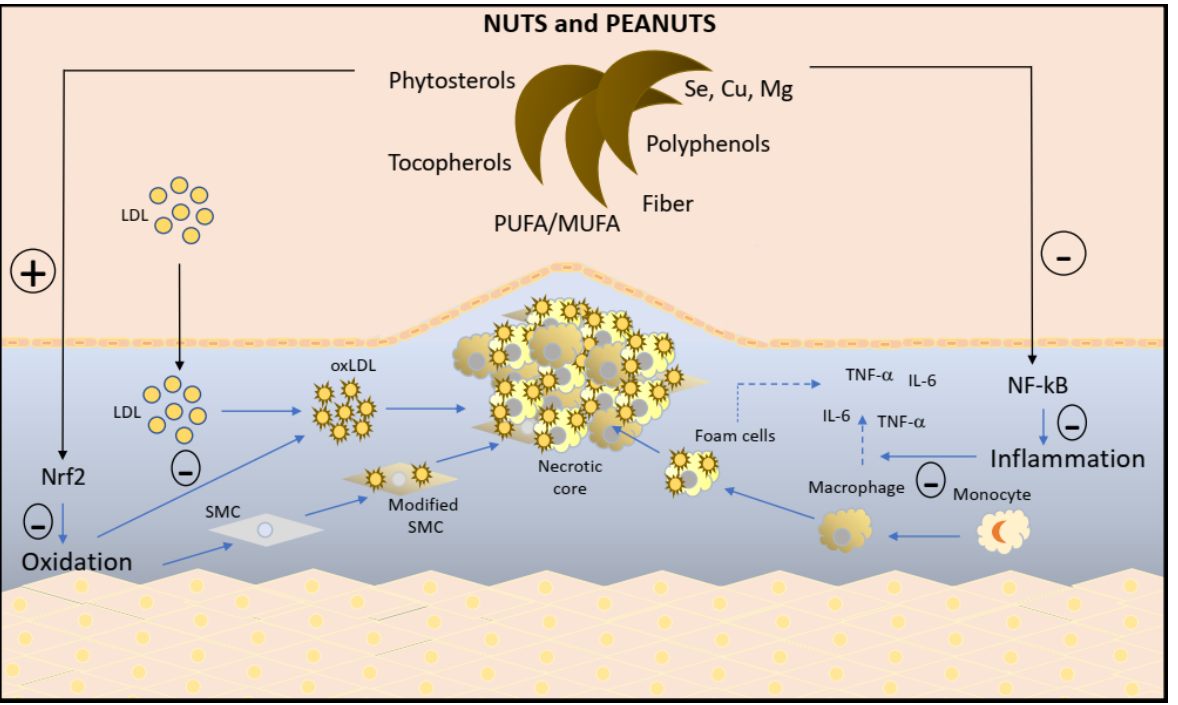
Figure 1. Inflammatory and oxidative processes modulated by nutrients and bioactive substances in tree nuts and peanuts. Fiber, phytosterols, PUFA/MUFA and mineral antioxidants such as Se, Cu, and Mg in tree nuts and peanuts can improve lipid metabolism through a cholesterol-lowering effect on low-density lipoprotein (LDL). Additionally, antioxidants (polyphenols and tocopherols) quench free radicals, avoiding the oxidative modification of LDL (oxLDL). Together, this process prevents monocyte migration and macrophage differentiation, and the consequent endocytosis of oxLDL by macrophages and the formation of foam cells. Increased levels of free radicals in the sub endothelial space stimulate changes in the smooth muscle cell (SMC) phenotype, favoring uptake of oxLDL. This complex process is essential to induce and maintain the low-grade inflammation characterized by the continuous synthesis of inflammatory cytokines (TNF- α , IL-6, and other markers) common in atherosclerosis and present in many other chronic diseases. Tree nuts and peanuts rich in bioactive substances can modulate multiple inflammation and oxidation pathways. Additionally, nut antioxidants can directly quench reactive oxygen species produced in the cell, reduce oxidative stress, and suppress NF κβ expression and downstream pro-inflammatory cytokine generation. Nut antioxidants are cofactors of several antioxidant enzymes. They can increase their activity, upregulate the gene expression of Nrf2, and increase the expression of antioxidant response element gene expression.